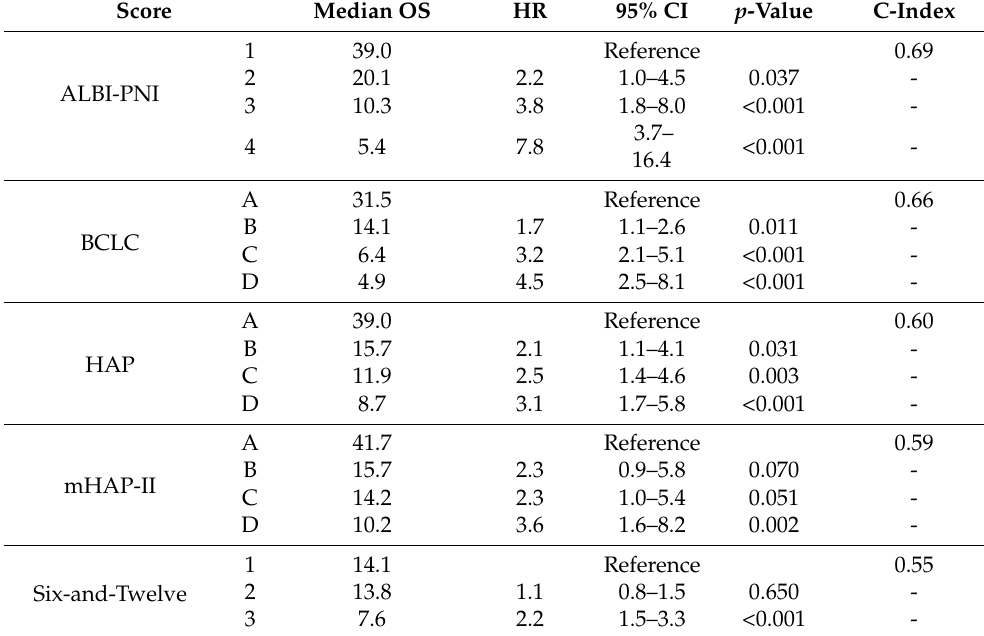
Table 4. Head-to-head comparison of the ALBI-PNI and different scoring